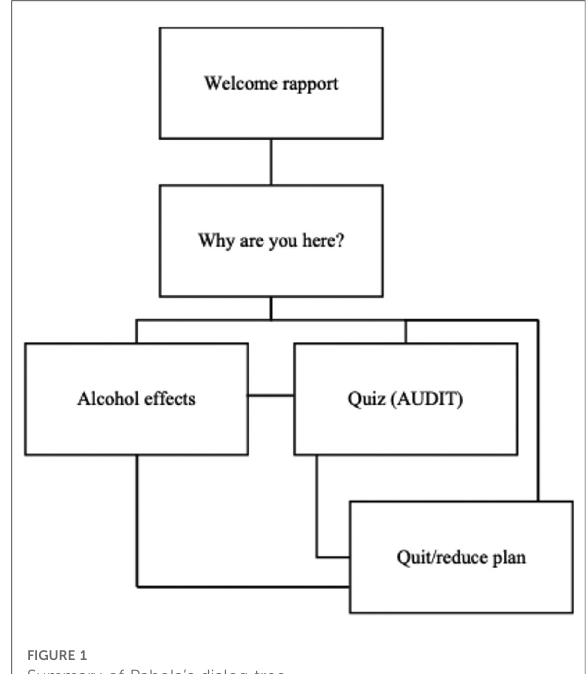
FIGURE 1 Summary of Pahola ’ s dialog